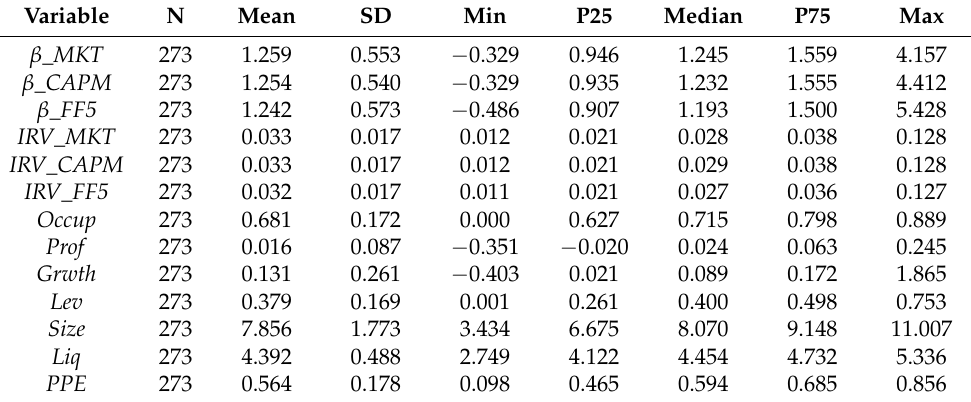
Table 1. Descriptive